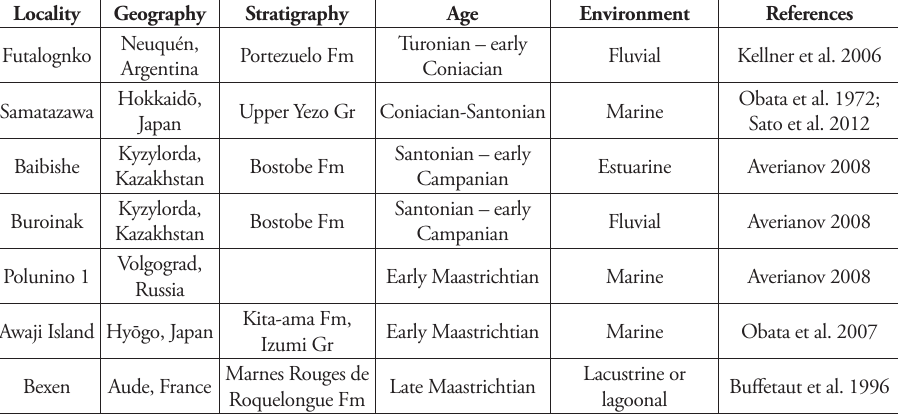
Table 2. Post-Cenomanian localities of Pterodactyloidea indet. which may belong to Azhdarchidae.